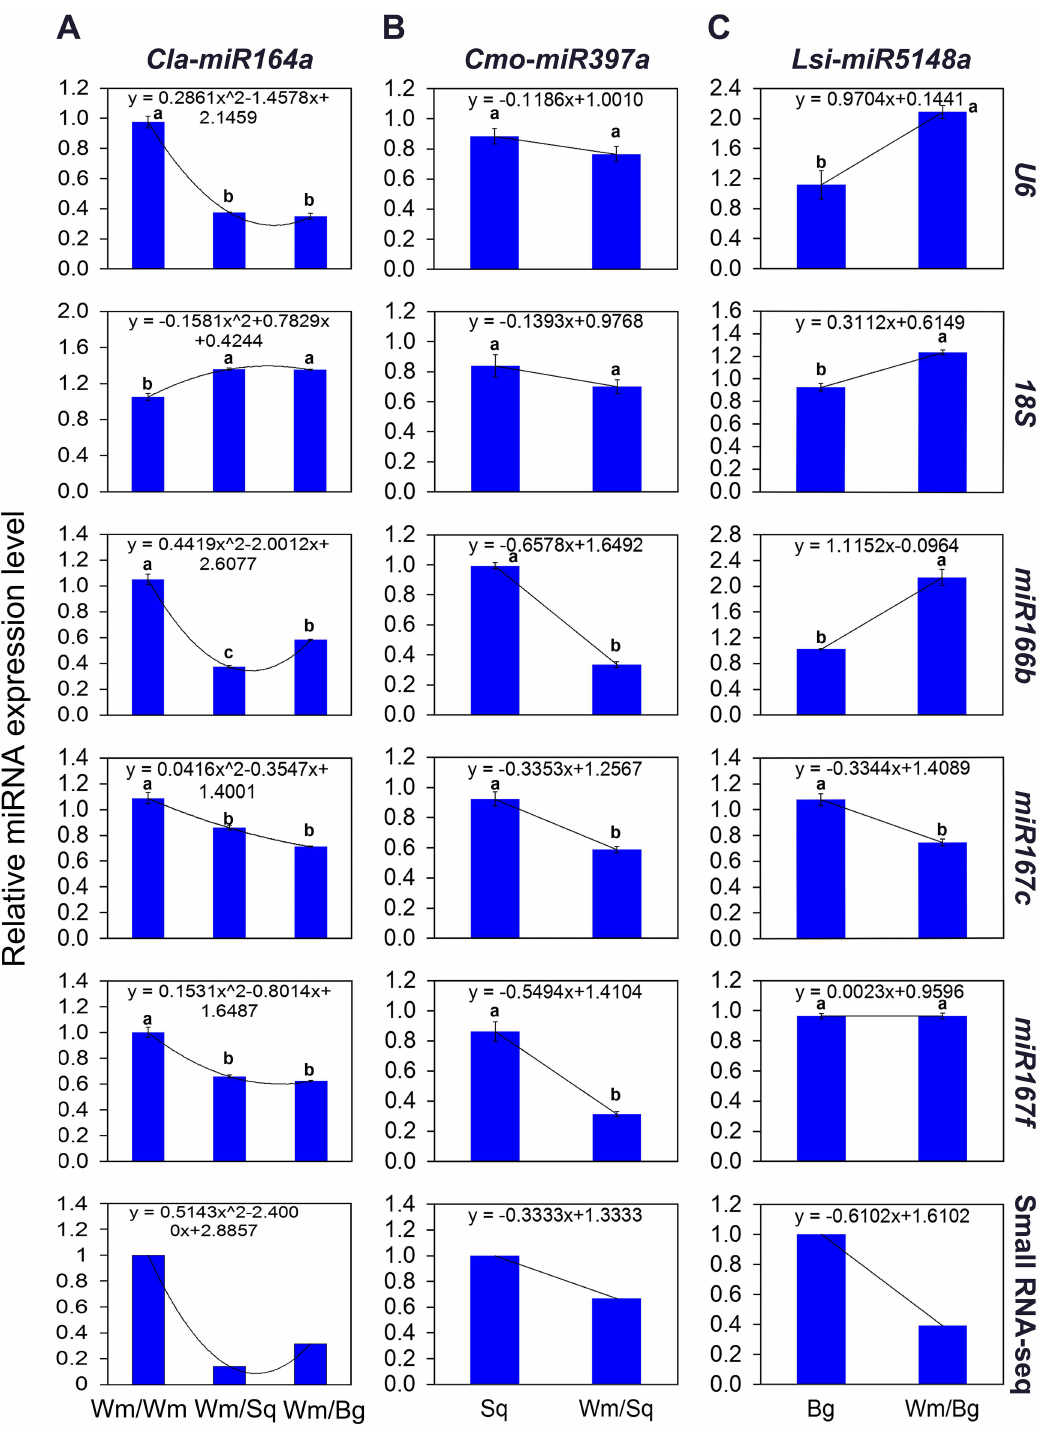
Fig 6. Expression profiles of target miRNAs in grafted watermelon under normal growth conditions. (A) Expression pattern of Cla-miR164a in the leaves of grafted watermelon scions. “Wm/Wm”, “Wm/Sq” and “Wm/Bg” represent self-, squash- and bottle gourd-grafted watermelon, respectively. (B) Expression pattern of Cmo-miR397a in squash roots. “Sq” and “Wm/Sq” represent non-grafted and grafted squash, respectively. (C) Expressionpattern of Lsi- miR5148a in bottle gourd roots. “Bg” and “Wm/Bg” represent non-grafted and grafted bottle gourd, respectively. qPCR data was normalized by each reference gene, including U6 , 18S , miR166b , miR167c and miR167f ,